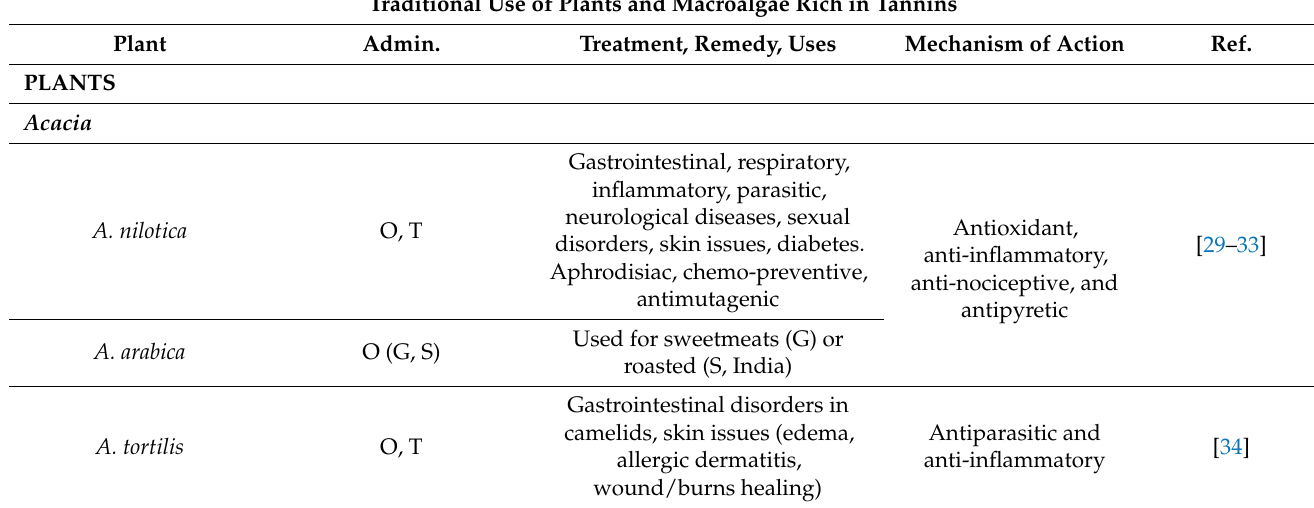
Table 1. Traditional applications of plants containing tannins. Selection of species and tissues rich in tannins traditionally applied under diverse administration ways (admin.) for treating different affections or diseases and the potential mechanism of action of their